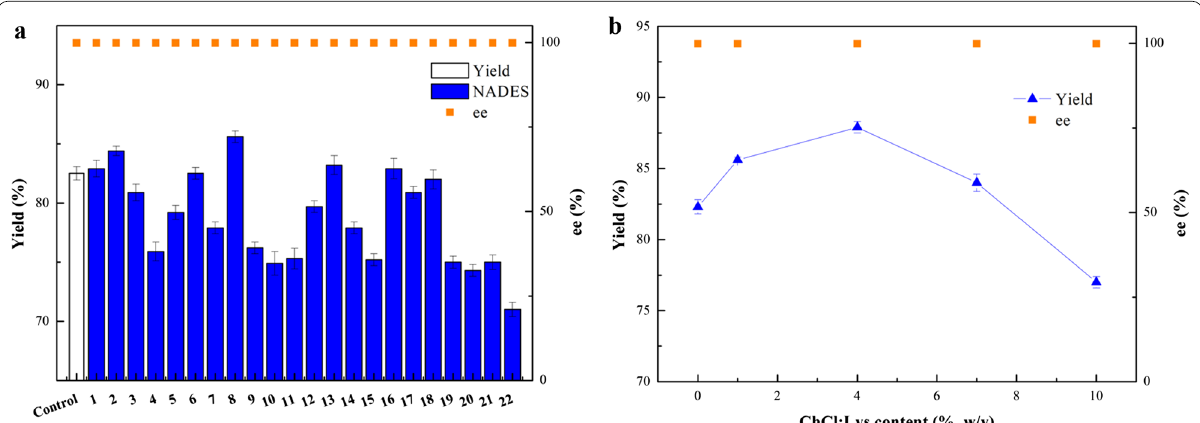
Fig. 4 Effect of various NADESs ( a ) and different ChCl:Lys content ( b ) on the ( R )-MTF-PEL production with recombinant E. coli cells. Reaction conditions: 200 mM 3’-(trifluoromethyl)acetophenone, 15% (v/v) isopropanol, 0.6% (w/v) Tween-20, 17.2 g (DCW)/L recombinant E. coli cells, PBS buffer (pH 7.5) ( a, b ), 1% (w/v) various NADESs ( a ), 30 ℃ , 200 rpm, 21 h; The number of various NADESs is listed in Table